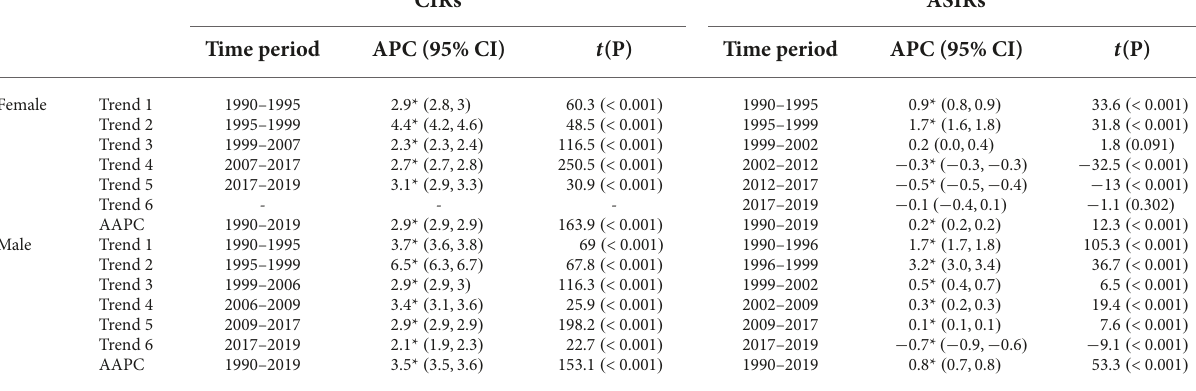
TABLE 1 Average and annual percent changes of PD incidence in China from 1990 to 2019.